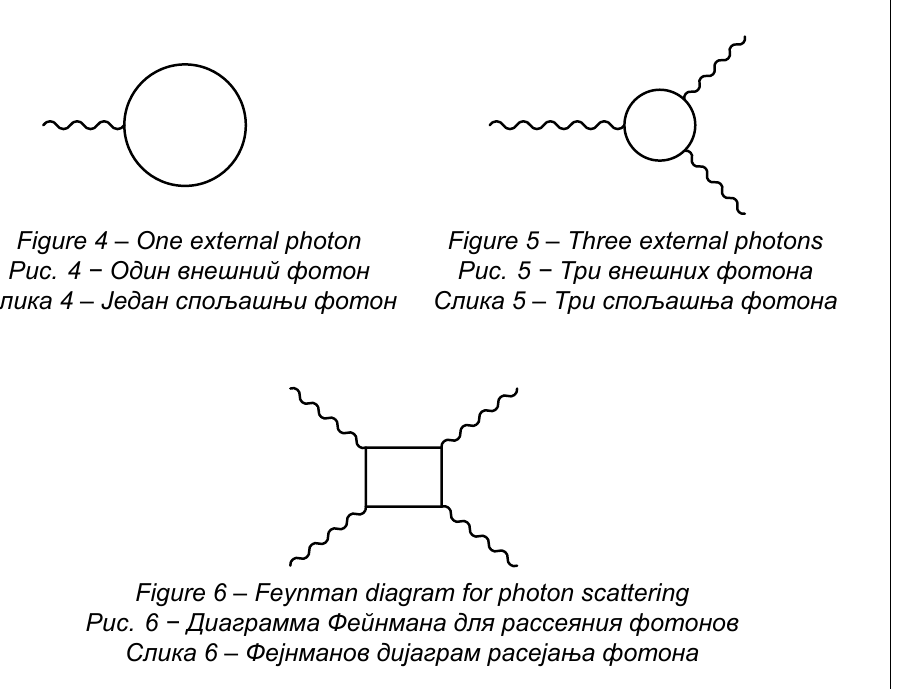
Figure 6 – Feynman diagram for photon